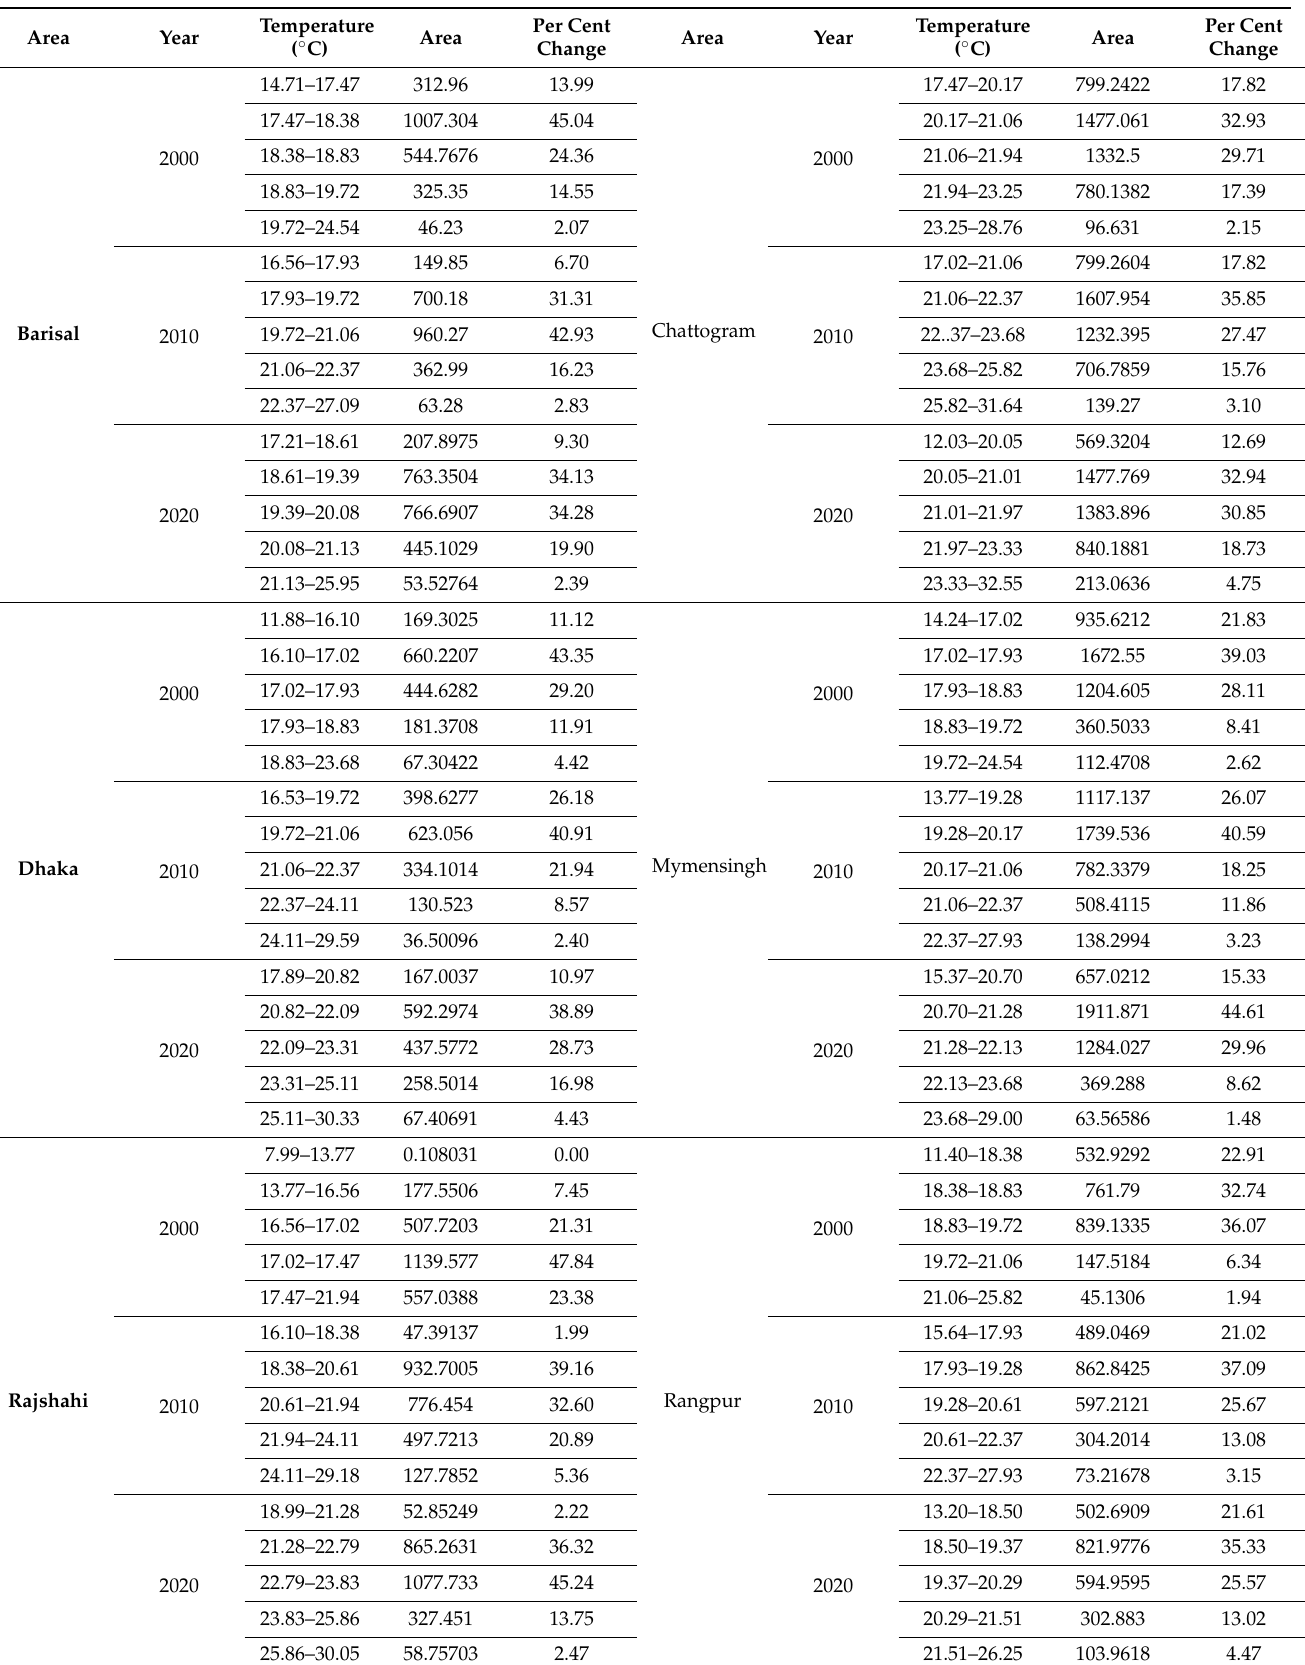
Table 5. LST area